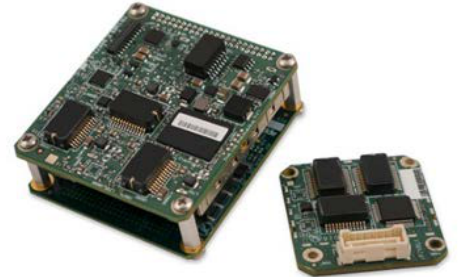
Figure 1: Trimble APX-15-EI UAV with onboard and remote IMU’s